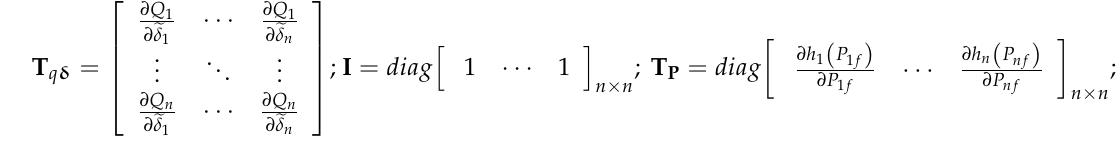
Figure 6. Root locus as the load resistance increases from 50 Ω to 100 Ω . Figure 7. Root locus by decreasing the line coupling inductance.